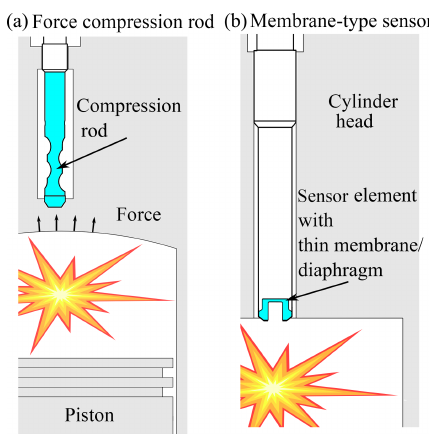
Figure 1. Different principles of cylinder pressure sensors. (a) Non- intrusive force compression rod. (b) Intrusive-membrane-based pressure